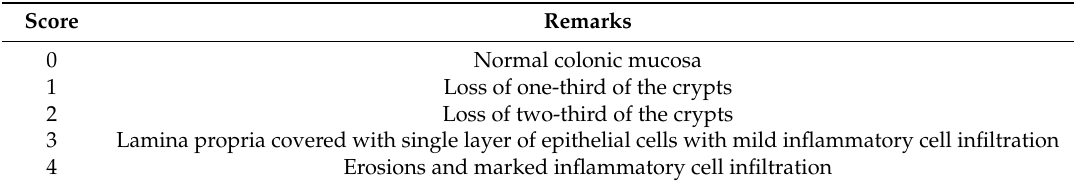
Table 2. Criteria for assessment of microscopic rectal